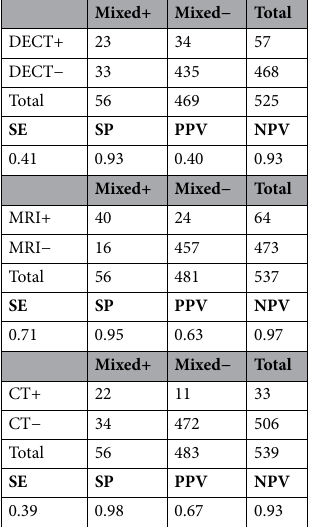
Table 5. Contingency table analysis of presence of mixed stenosis for DECT, MRI, and CT with both MRI and standard CT as standard of reference. Data are given with 95% confidence intervals. SE sensitivity, SP specificity, PPV positive predictive value, NPV negative predictive value, MRI magnetic resonance imaging, CT computed tomography, DECT dual-energy computed tomography, + mixed stenosis, − discoid, osseous, or no